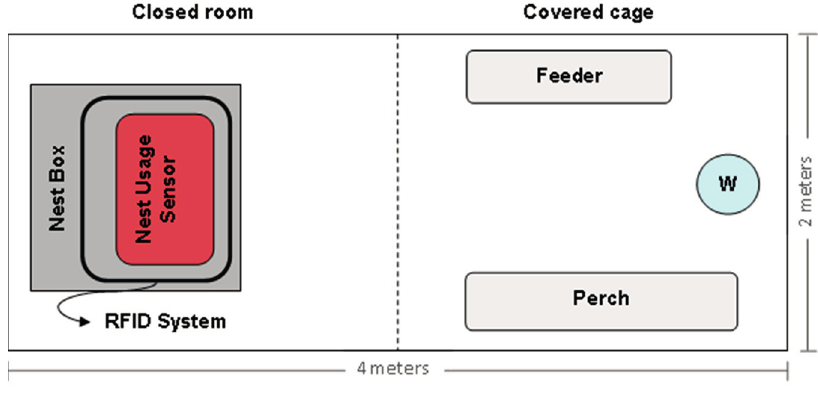
Figure 3. Diagram of the experimental building set-up. The positioning of the nest box, the nest usage sensor and of some main components is reported. The symbol “W” represents the water